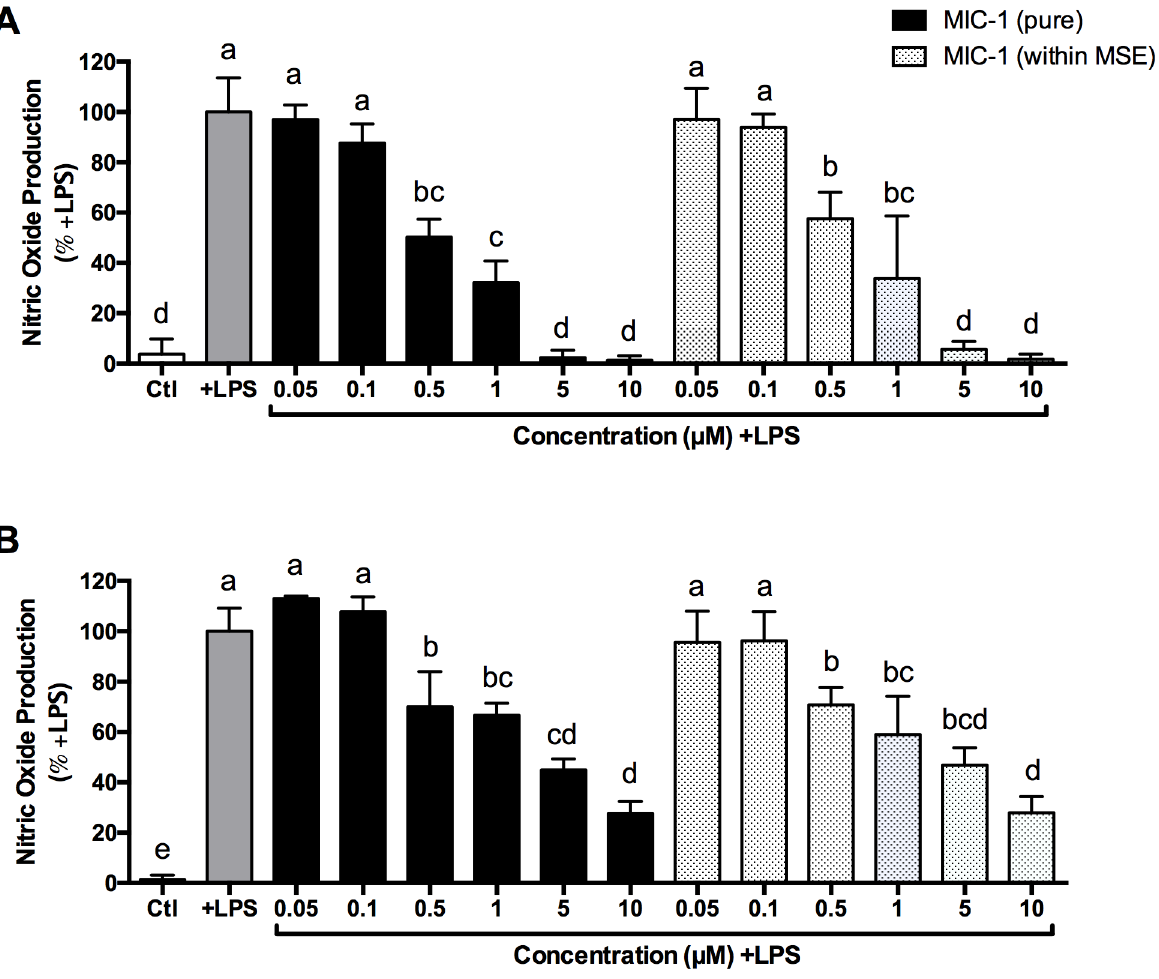
Fig 5. Effects of equivalent concentrations of MIC-1 (0.05, 0.5, 0.1, 1, 5, and 10 μ M), delivered as a pure compound or as complex MSE, on NO production in LPS-stimulated RAW 264.7 murine macrophages. NO productionin cells treated for A) 8 h and B) 24 h, comparedto vehicle-treated control without LPS (Ctl) and LPS-stimulatedcontrol (+LPS). Data are the mean ± SD (n = 3–6). Different letters indicatesignificantdifferences, one-wayANOVA followedby Tukey’s post hoc